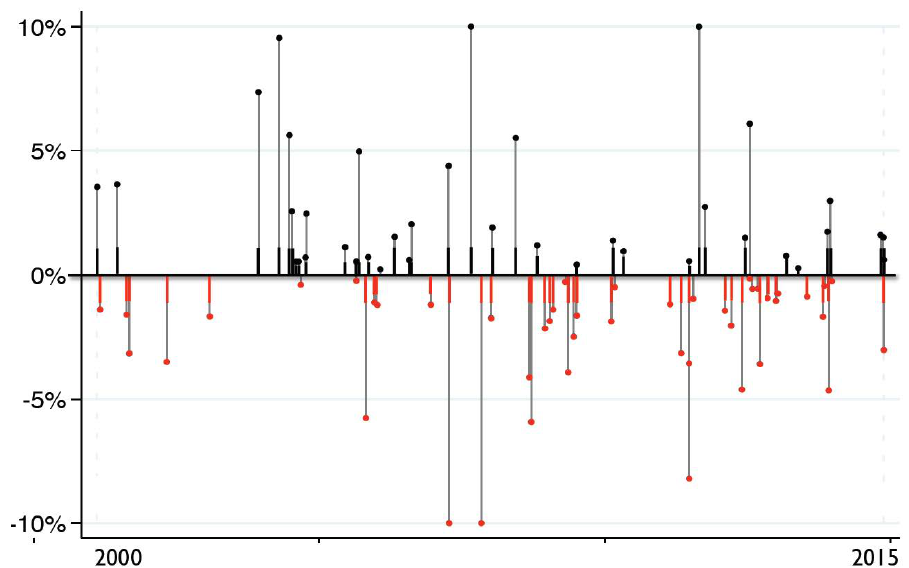
Figure 1: Market reaction (CAR) for female CEO